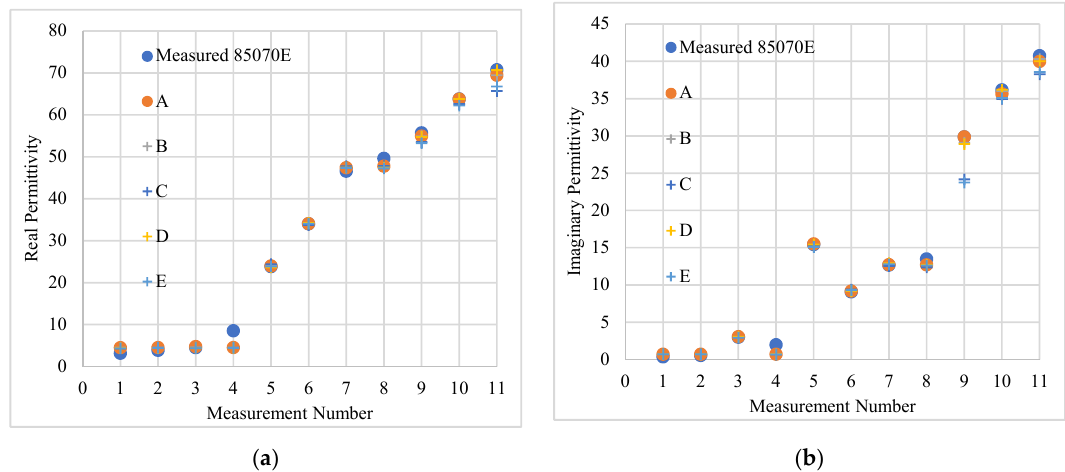
Figure 11. The computed and measured real ( a ) and imaginary part ( b ) of the complex permittivity for all testing data (eleven samples) at 2.45 GHz, considering both scenarios. Scenario 1 included noise added only to the training and validation data while Scenario 2 features noise in all training, validation and testing data. The measured data was obtained using the Slim Form probe and the input data (S11) was obtained with the VNA calibrated at the test port (reference plane B in Figure 1). Key: A—Raw data, B—Raw and noisy input data 1, C—Raw and noisy input data 1 with noisy test data, D—Raw and noisy input data 2, E—Raw and noisy input data 2 with noisy test data.